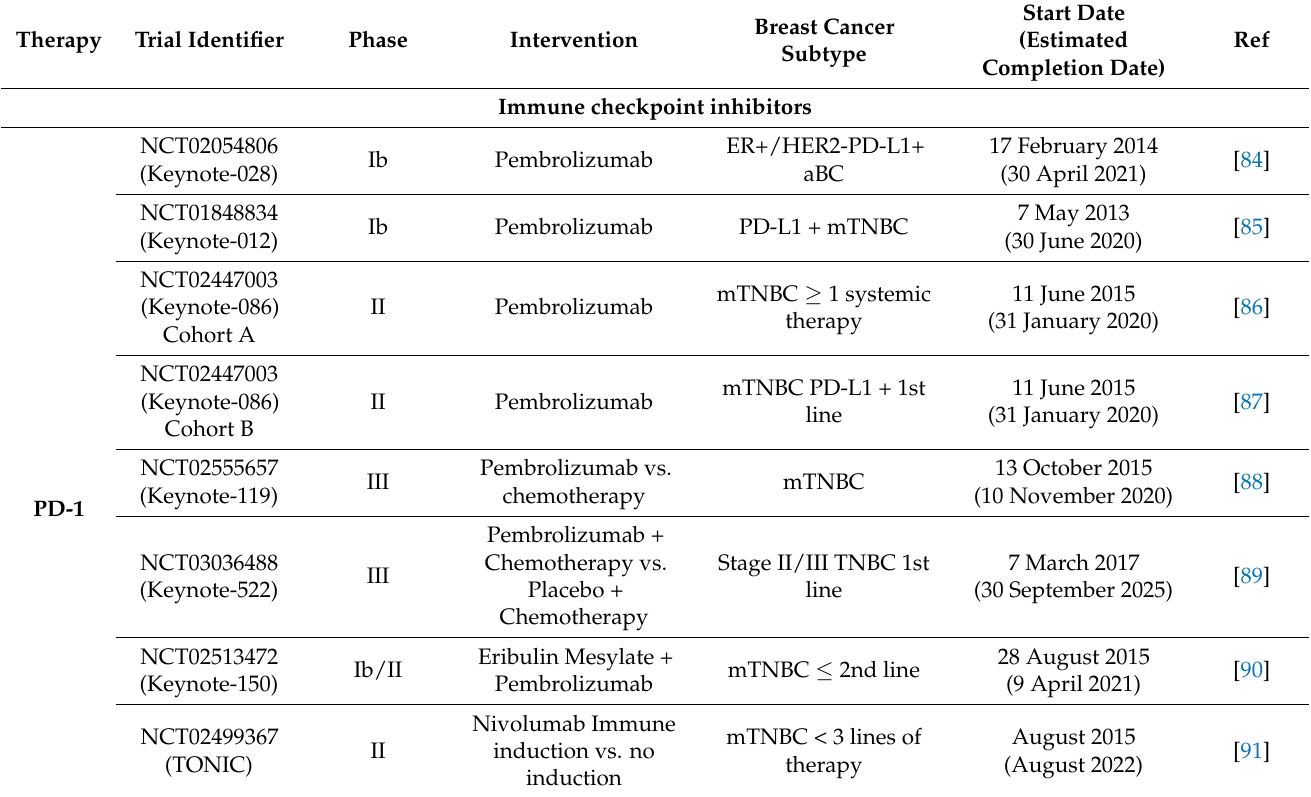
Table 1. Summary of immunotherapy clinical trials in breast